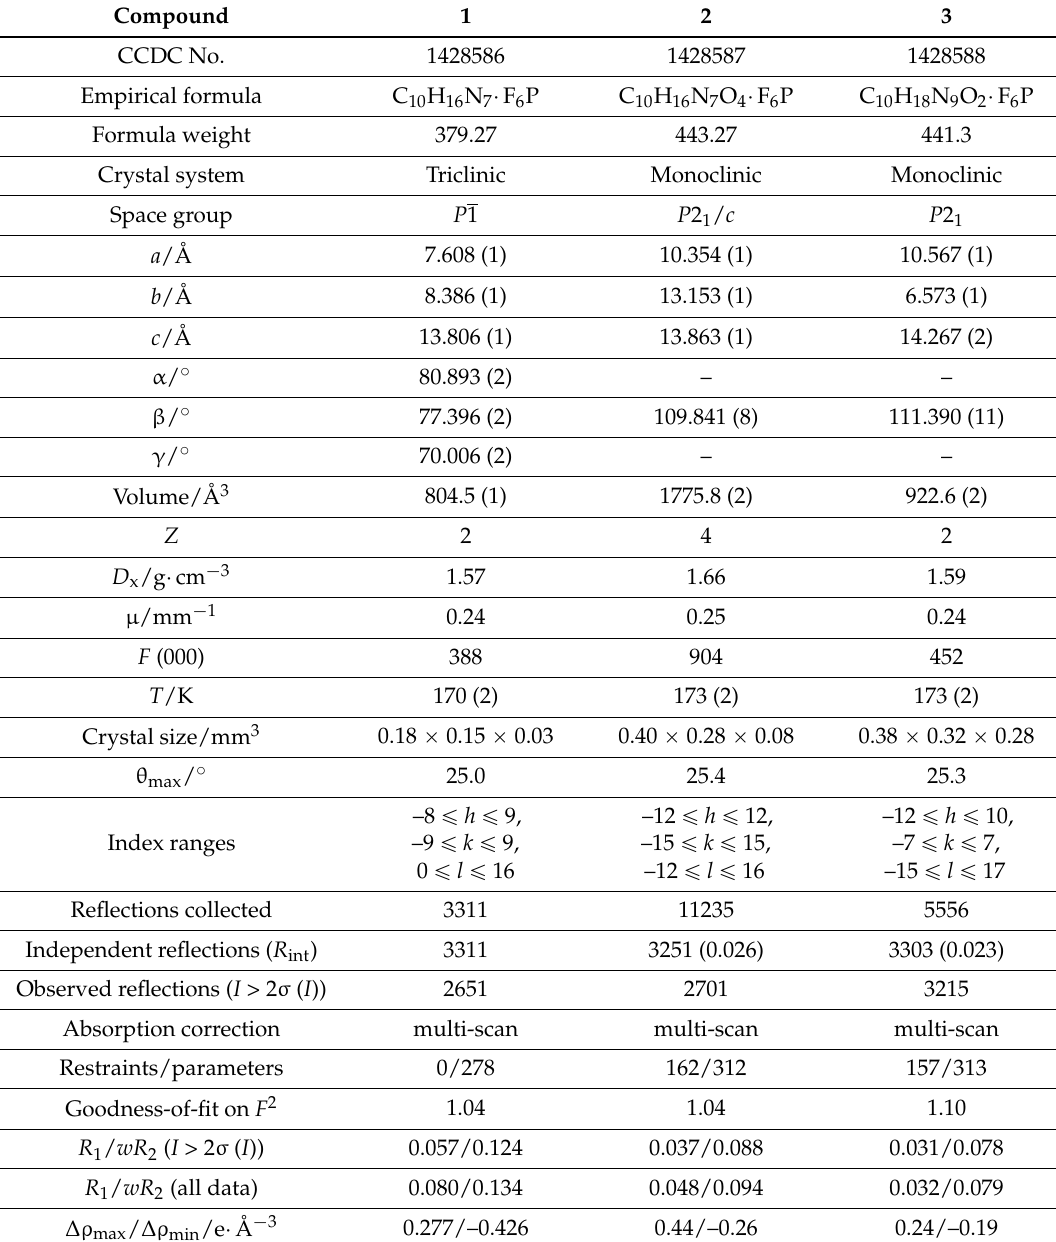
Table 1. Crystal data and structure refinement for 1 – 3